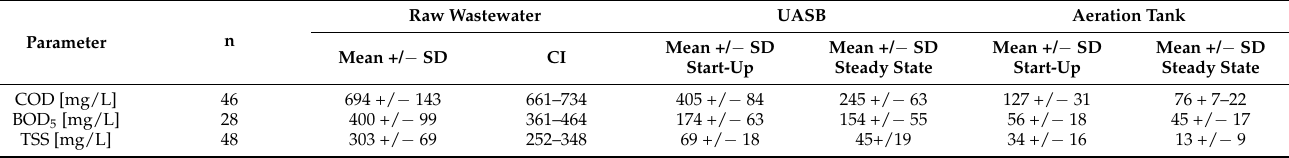
Table 5. STP effluent COD, BOD, and TSS concentrations at the start-up and in the steady state.